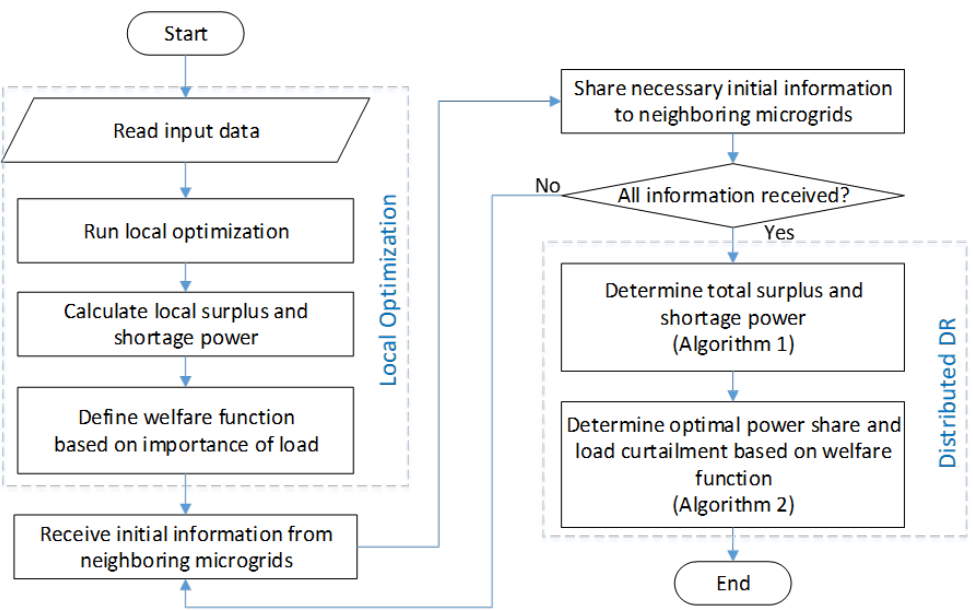
Figure 4. Flowchart for the proposed operation of a microgrid in the network.